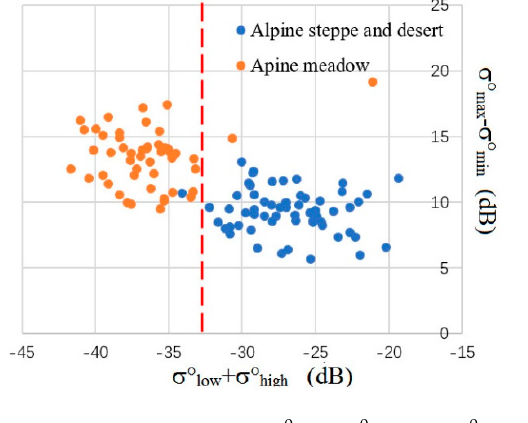
Figure 7. Scatter plot between the ( σ (cid:2923)(cid:2911)(cid:2934)(cid:2868) − σ (cid:2923)(cid:2919)(cid:2924)(cid:2868) ) and ( σ (cid:2922)(cid:2925)(cid:2933)(cid:2868) + σ (cid:2918)(cid:2919)(cid:2917)(cid:2918)(cid:2868) ).